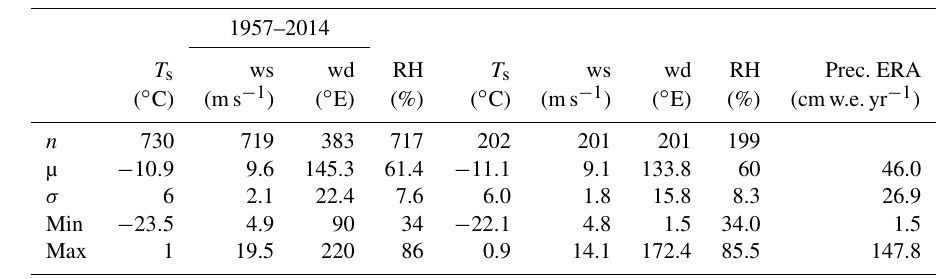
Table 2. Number of points ( n ), time averages (µ), standard deviation ( σ ), minimum (min), and maximum (max) values of all the monthly meteorological observations at Dumont d’Urville from Météo France over the period 1957–2014 (with a gap between March 1959 and January 1960, inclusive) and over the period 1998–2014 for near-surface temperature ( T s , ◦ C), wind speed (ws, ms − 1 ) , wind direction (wd, ◦ E), relative humidity (RH, %), and annual precipitation and accumulation (precipitation minus evaporation and sublimation) from